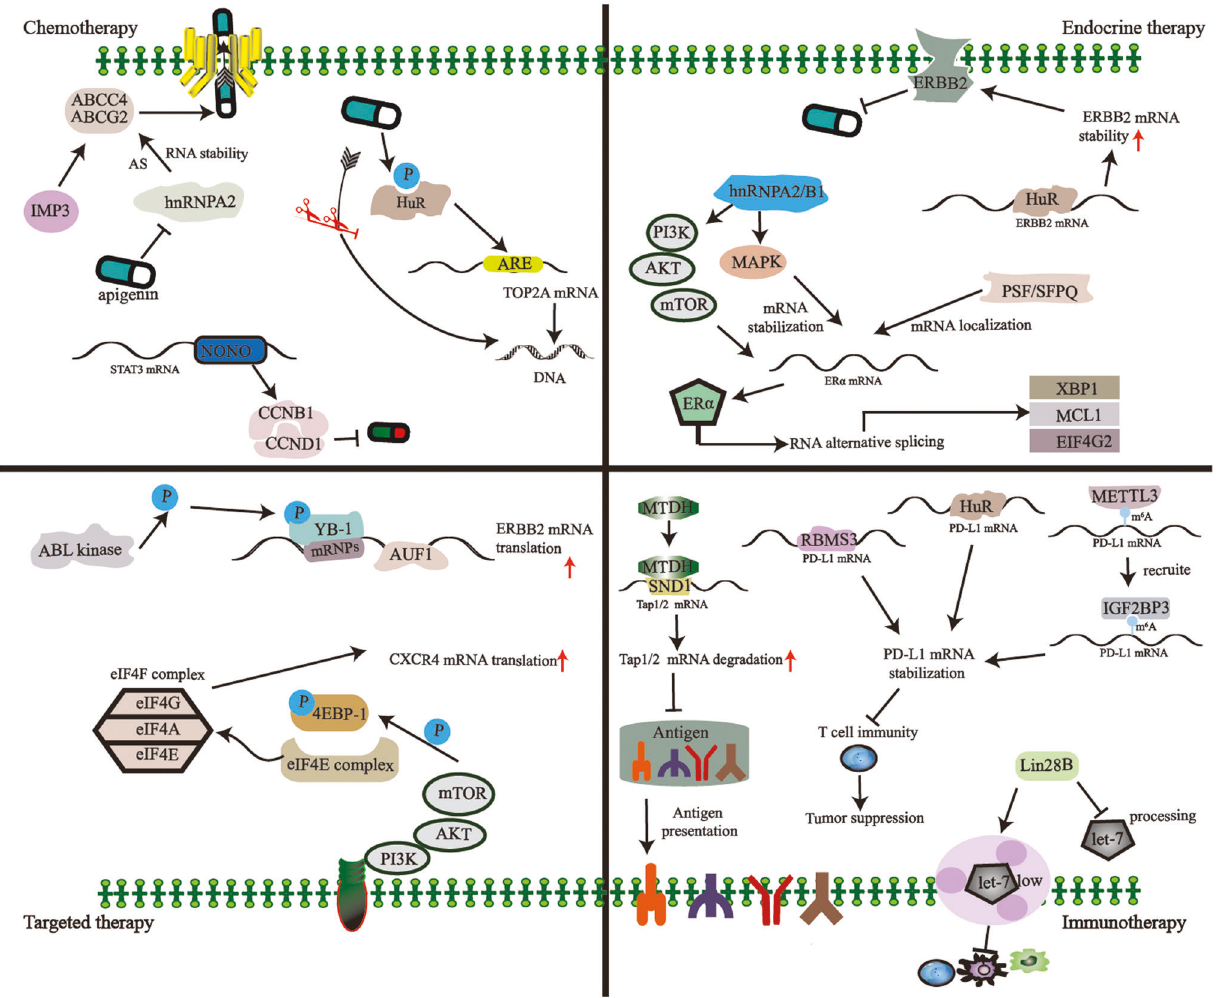
Fig. 2 RBPs modulate treatment resistance of breast cancer. The abnormal expression and interaction of RBPs in fl uence treatment resistance by regulating various post-transcriptional events. Representative mechanisms of RBPs regulating resistance of chemotherapy, endocrine therapy, targeted therapy and immunotherapy are shown in respective panel in the schematic